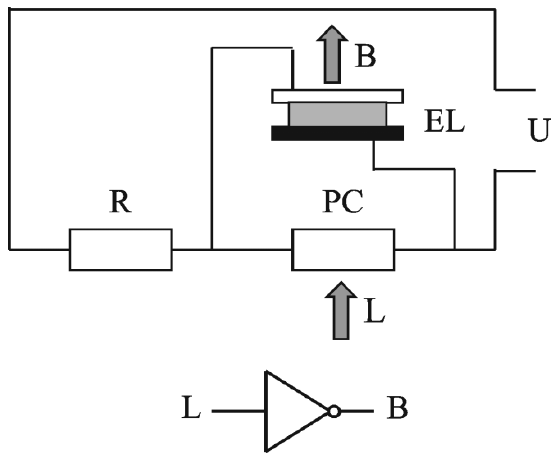
FIGURE 3 Optoelectronic NOT